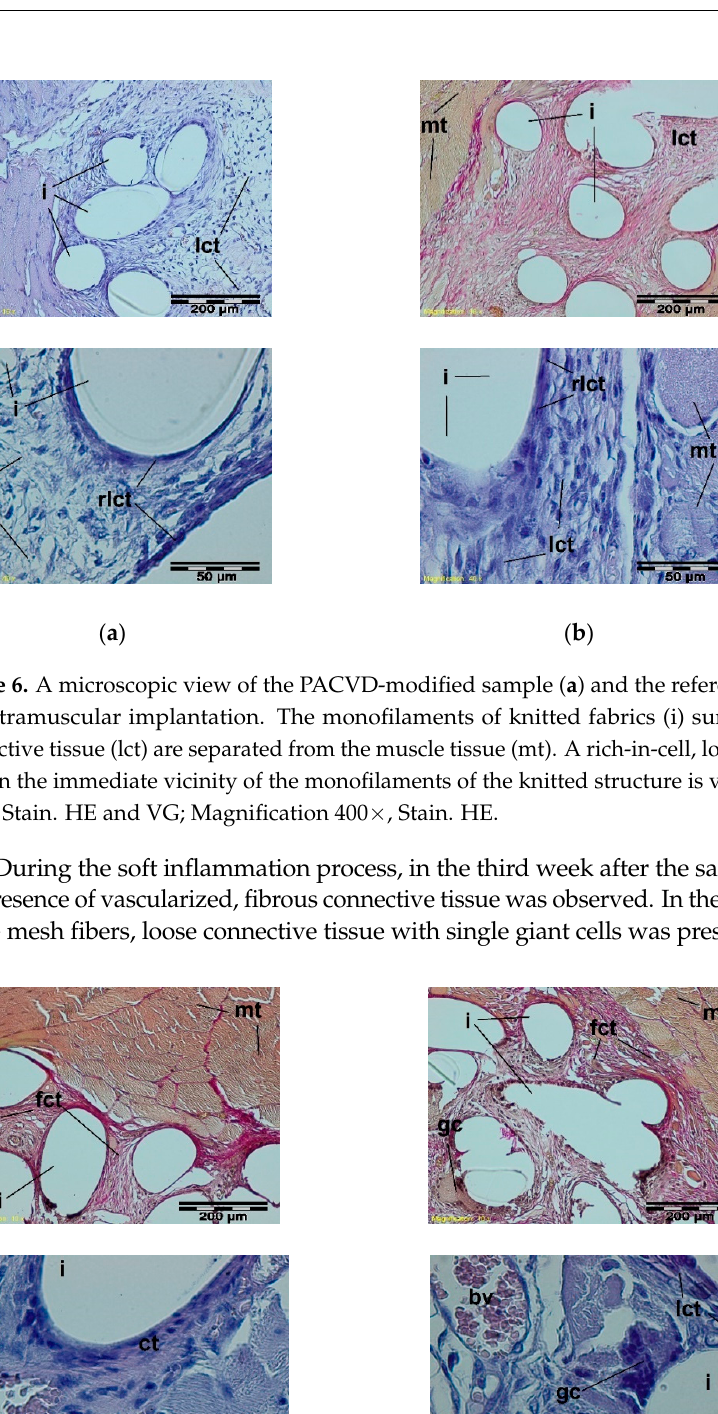
from the muscle tissue (Figure 6).